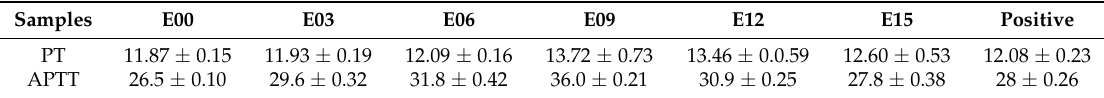
Table 3. PT (prothrombin time) and APTT (activated partial thromboplastin time) of samples.